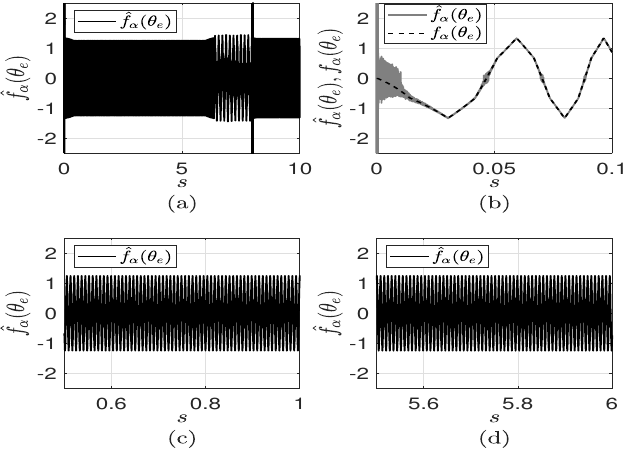
Figure 16. ( a ) Estimated back-EMF fundamental function ˆ f α ( θ e ) . ( b ) Transient response close up of the estimation of the observer. ( c ) Zoom of ˆ f α ( θ e ) estimation at 0.5 s ≤ t < 1 s. ( d ) Zoom of ˆ f α ( θ e ) estimation at 5.5 s ≤ t < 6 s.